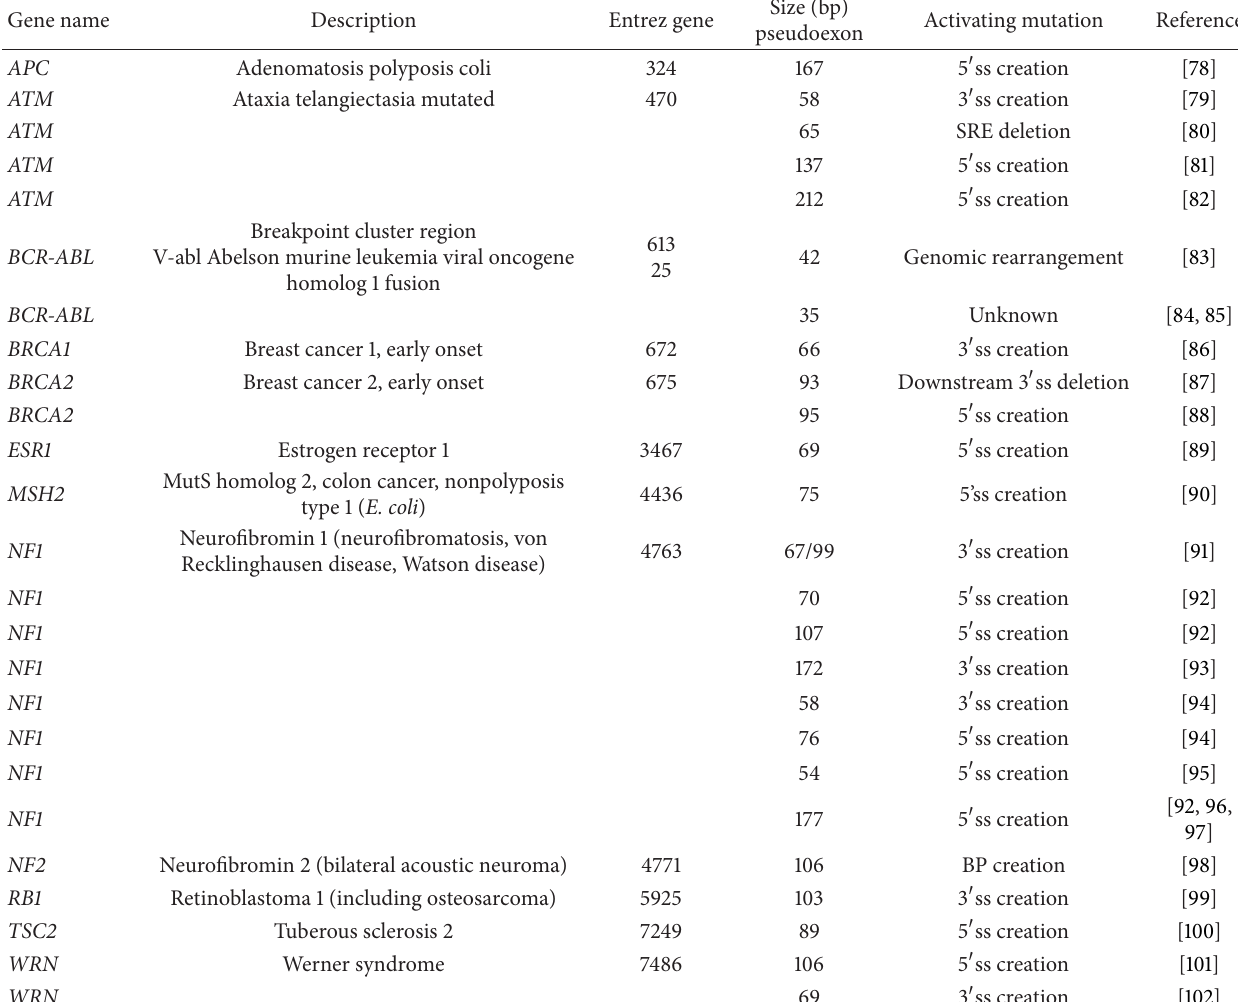
Table 2: Pseudoexon insertion events directly involved in cancer